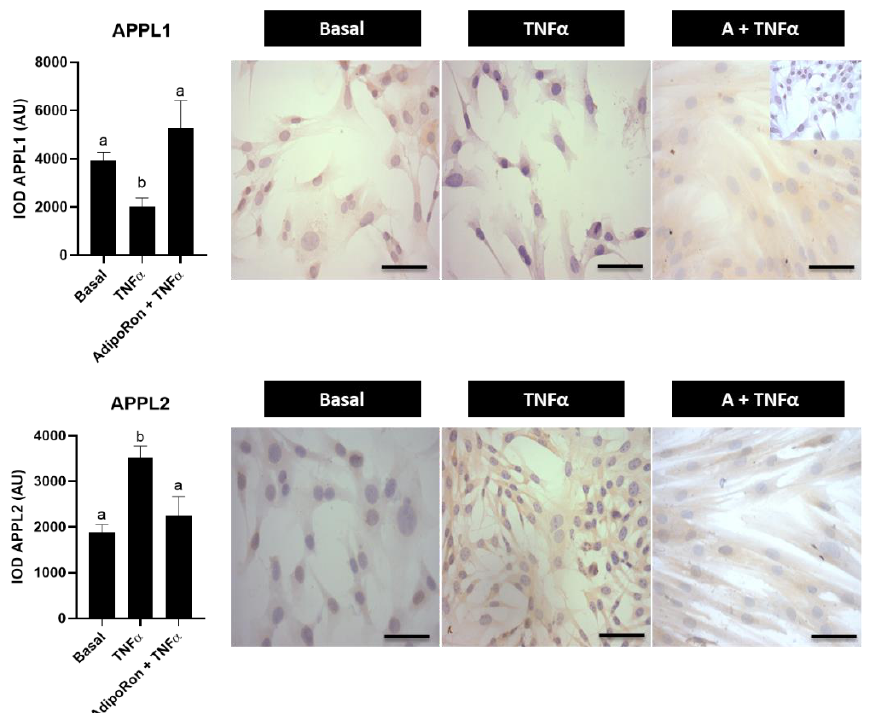
Figure 6. Effect of AdipoRon on the expression of adiponectin signaling-associated molecules in human endometrial cells exposed to TNF α treatment. APPL1 and APPL2 protein levels in human endometrial cells treated for 24 h with TNF α (100 ng/mL) with or without AdipoRon (A, adiponectin agonist) (30 µM) by immunocytochemistry (ICC). Photomicrographs show the tissue locations of APPL1 and APPL2 by immune-positive brown color staining in each sample. The graphs show the semi-quantification obtained by the IOD tool. Inner box: negative control; bar = 50 μm; images at 400× (in (A): image of 200× in inner box). Three independent experiments were performed for each treatment ( n = 3; in duplicate). In the graphs, a ≠ b indicates a statistically significant difference with a p -value < 0.05. Non-parametric test and Dunn’s post hoc test. Data are shown as mean AU (arbitrary units) ± SEM.